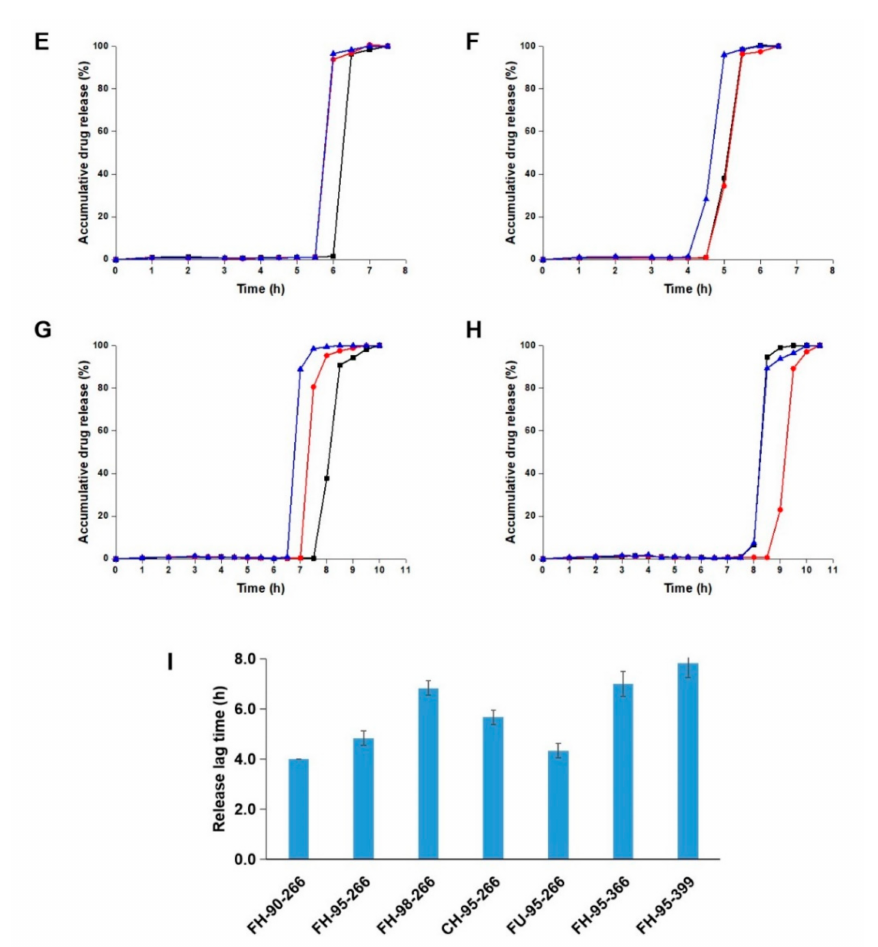
Figure 9. In vitro drug release from ( A ) commercial tablet, ( B ) FH-90-266, ( C ) FH-95-266, ( D ) FH-98- 266, ( E ) CH-95-266, ( F ) FU-95-266, ( G ) FH-95-366, ( H ) FH-95-399; ( I ) comparison of the release lag time of the 3D-pinted tablets ( n =